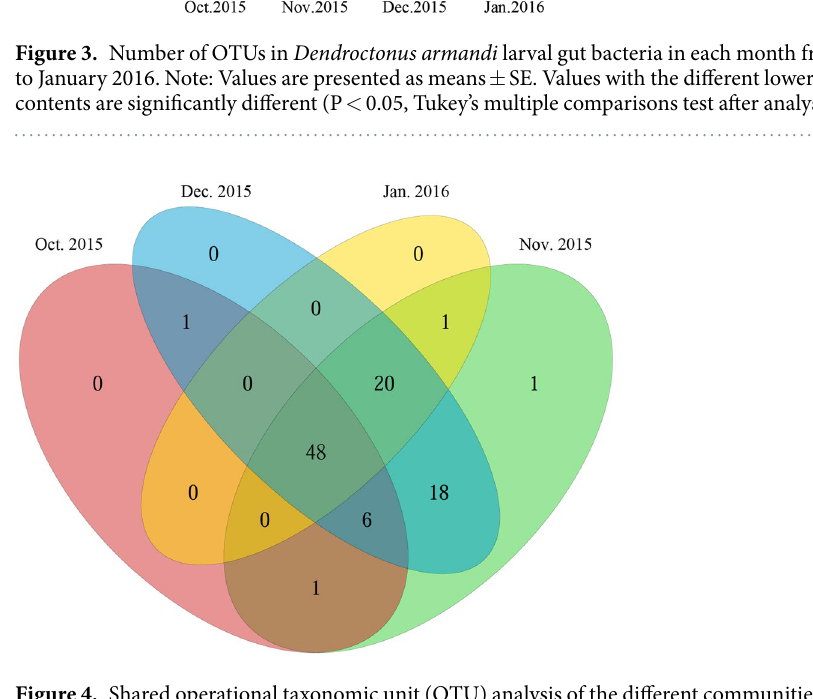
Figure 4. Shared operational taxonomic unit (OTU) analysis of the different